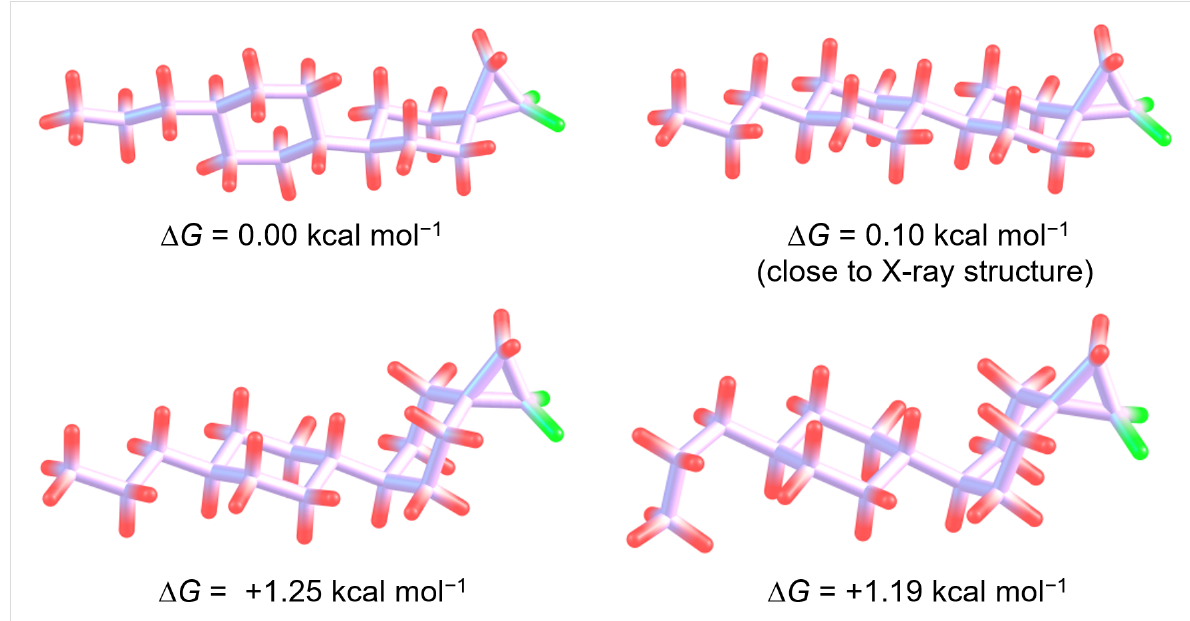
Figure 3: Theory study exploring the relative energies for different conformers of 11a